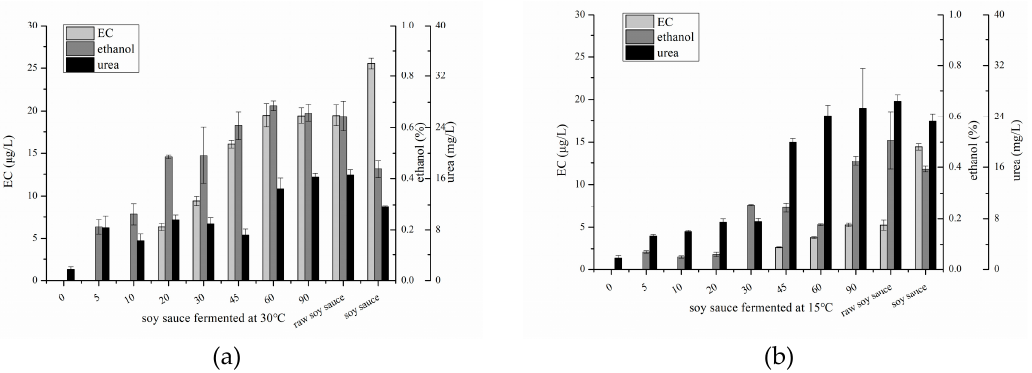
Figure 2. Changes of ethyl carbamate, ethanol and urea contents in soy sauce fermented at 30 °C ( a ) and 15 °C ( b ), respectively.